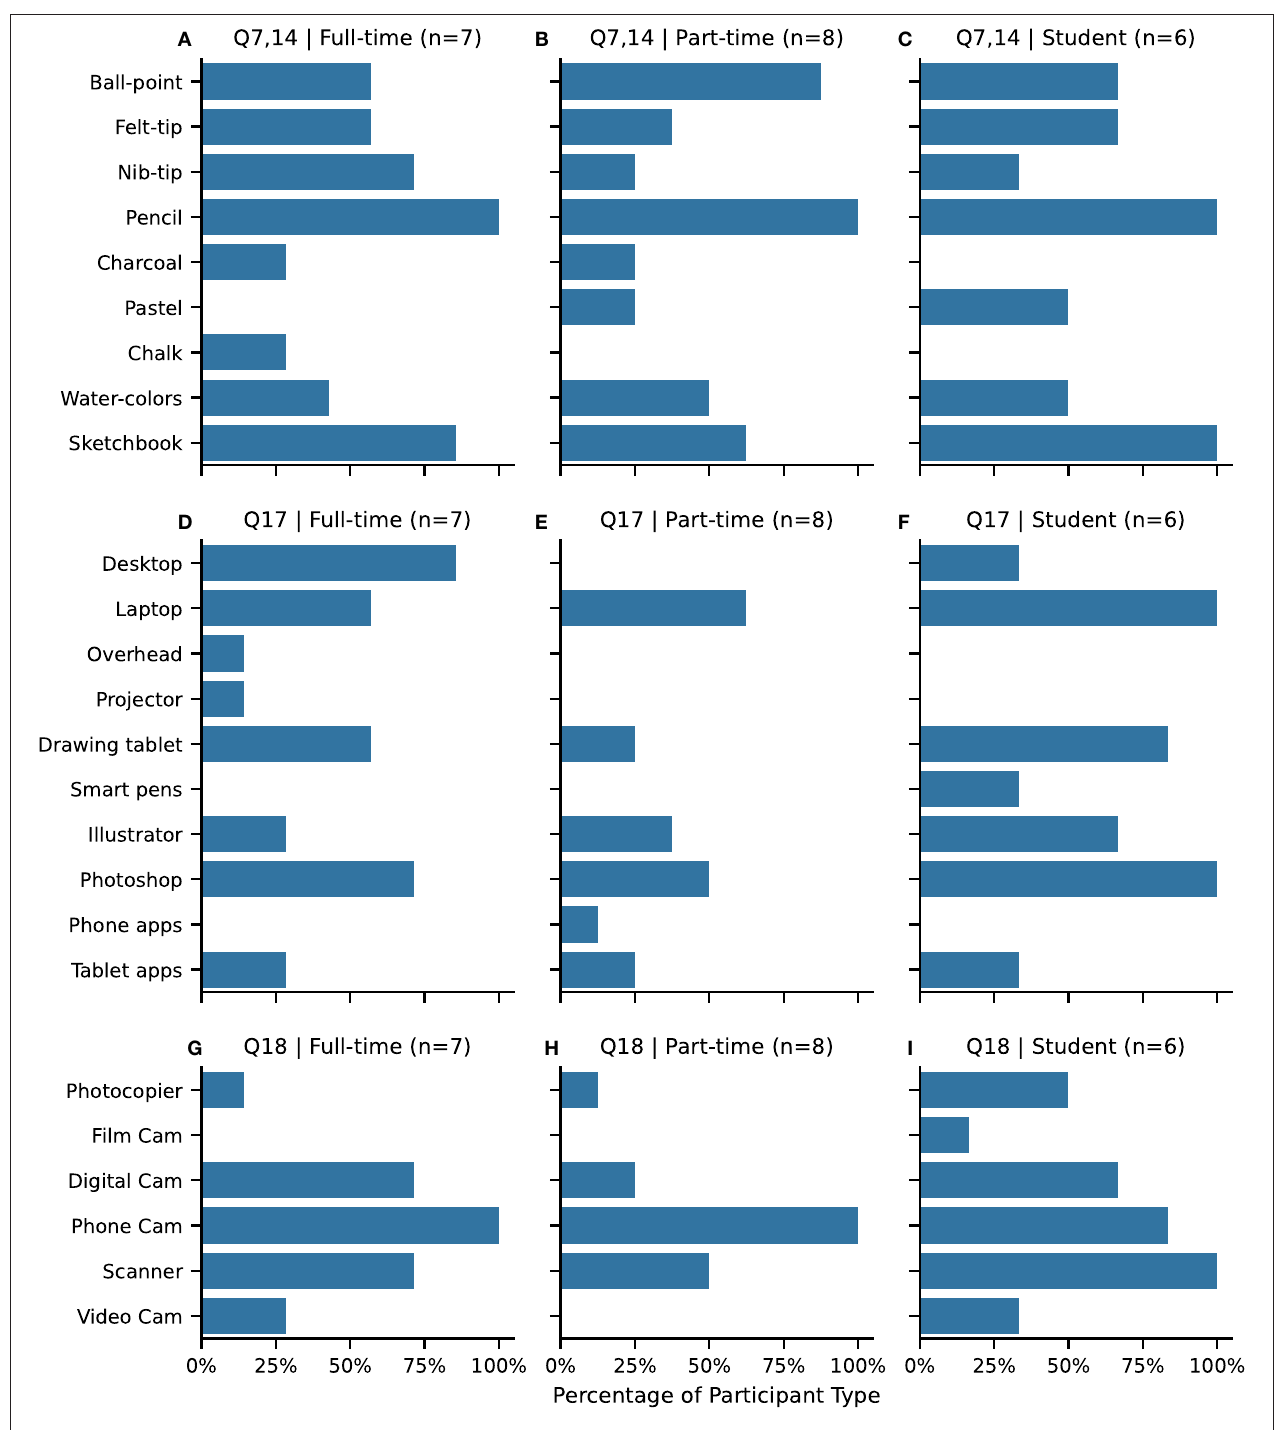
FIGURE 3 | (A–C) Q7. Drawing materials, including pens ( ball-point , felt-tip , nib-tip ) and Q14. sketchbook usage. (D–F) Q17. Technology used for drawing, including desktop computers, laptop computers, analog overhead projectors, digital projectors , Adobe Illustrator , Adobe Photoshop , mobile phone drawing app lications, tablet (e.g., iPad) drawing app lications. (G–I) Q18. Drawing capture technology, including analog film cam era, digital cam era, mobile phone cam era, digital scanner , digital video cam era. Abbreviations are in bold . Participants selected all answers that apply for all questions.